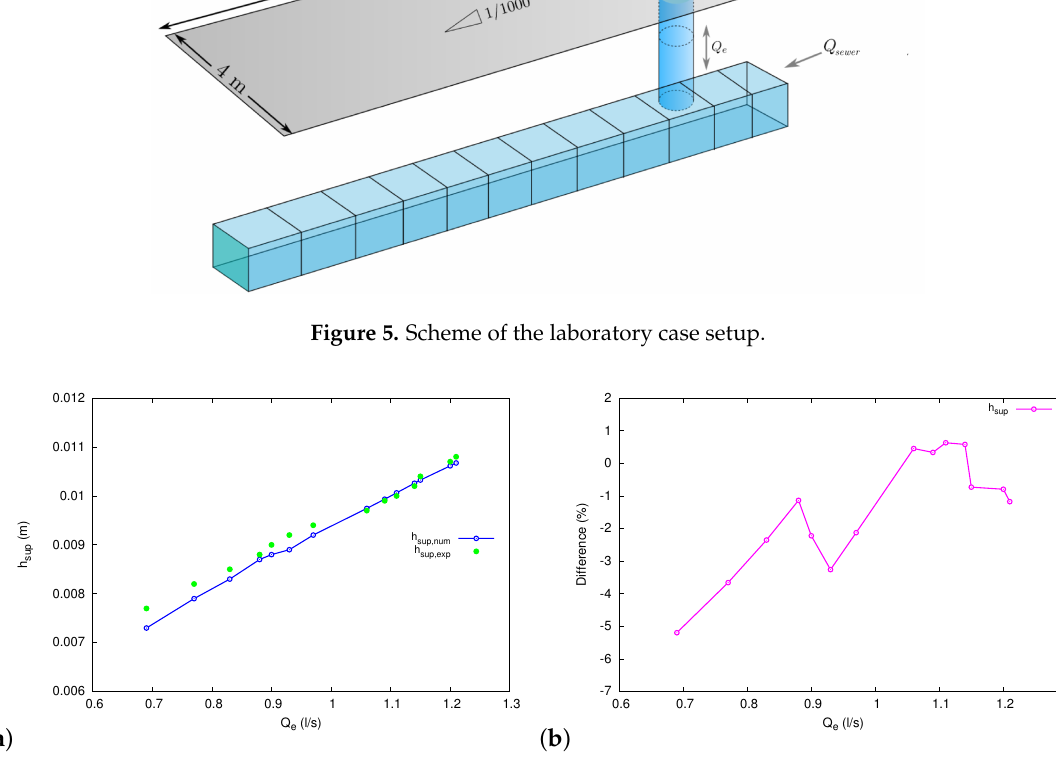
Figure 6. Case 1.1. Comparison between numerical and experimental data ( a ) and relative differences (%) ( b ) for the surface water